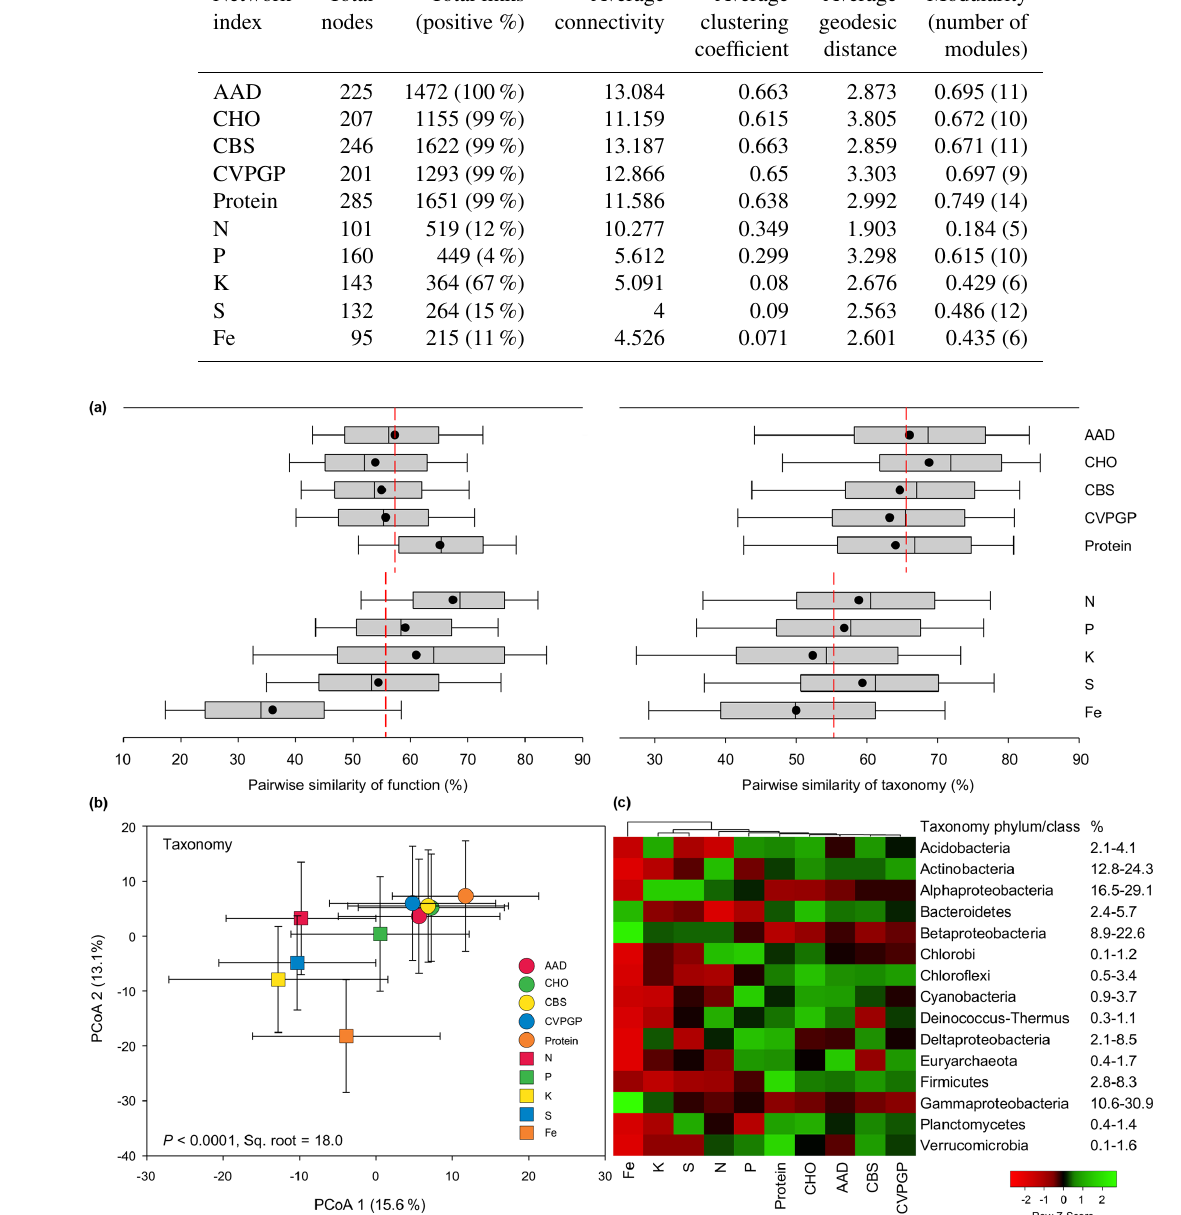
Figure 2. Functional and taxonomic diversities for broad versus narrow functions. (a) Box plots and mean values of pairwise Bray–Curtis similarity of microbial functional diversity and of pairwise Bray–Curtis similarity of taxonomic diversity for broad versus narrow functions. (b) PCoA (principal coordinates analysis) showing microbial taxonomic beta diversity for broad and narrow functions annotated using RefSeq at genus level (taxonomy). The error bars represent standard deviations of data ranges. Variations (by percentage) explained by the two principal coordinate dimensions are given in parentheses. The P value and the square root of PERMANOVA are also given. (c) Heatmap showing the relative abundances of dominant microbial taxonomic compositions (mean > 0 . 5%) for broad and narrow functions annotated using RefSeq at the phylum/class level (taxonomy). Broad functions include AAD (amino acids and derivatives), CHO (carbohydrates), CBS (clustering-based subsystems), CVPGP (cofactors, vitamins, prosthetic groups, pigments), and Protein (protein metabolism); narrow functions include N (nitrogen metabolism), P (phosphorus metabolism), K (potassium metabolism), S (sulfur metabolism), and Fe (iron acquisition and